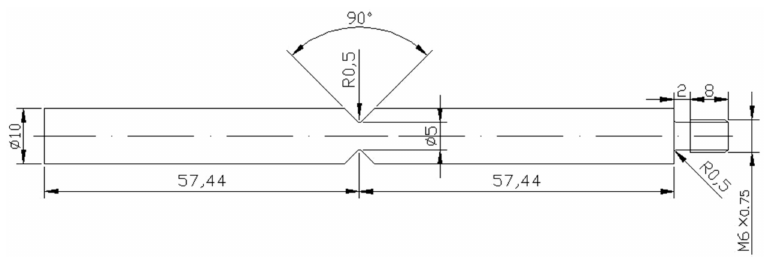
Figure 2. Shape and dimensions of the smooth specimens (units: mm).